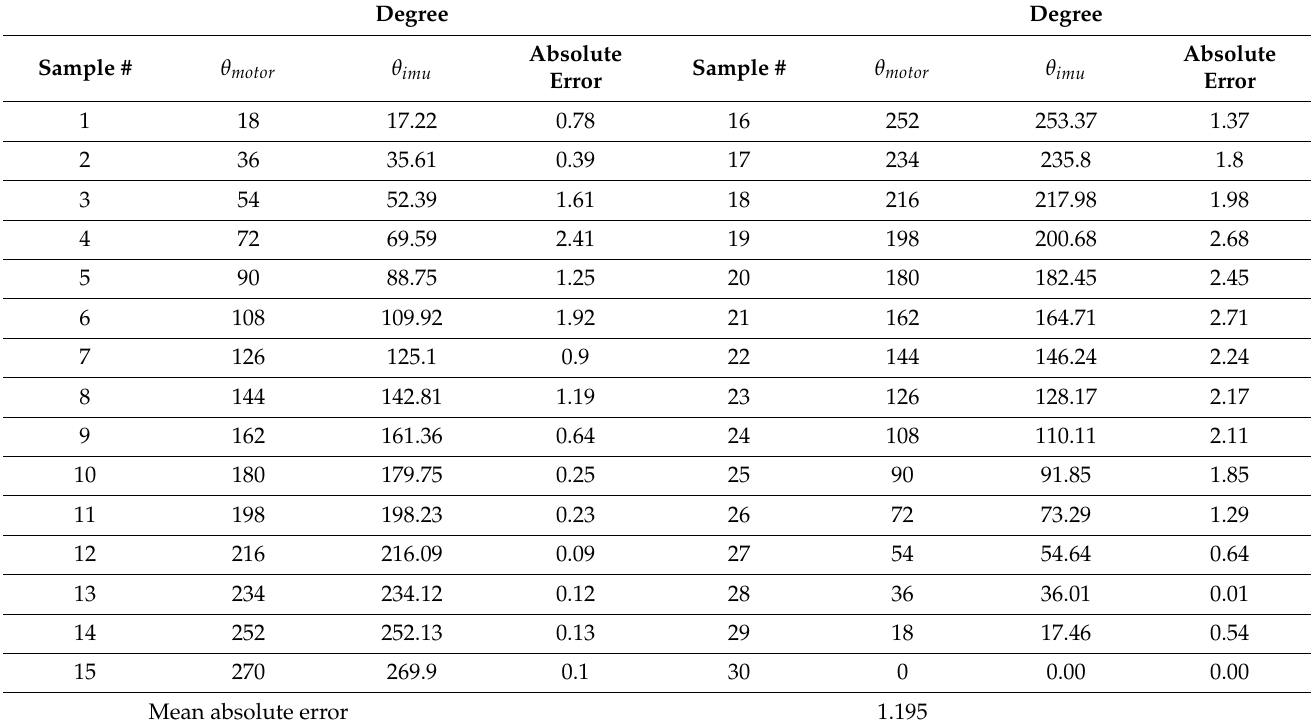
Table 3. Z -axis rotation angle experimental